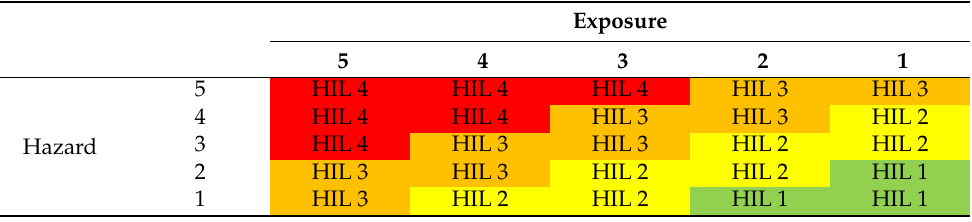
Table 7. Category table for hazard integrity level